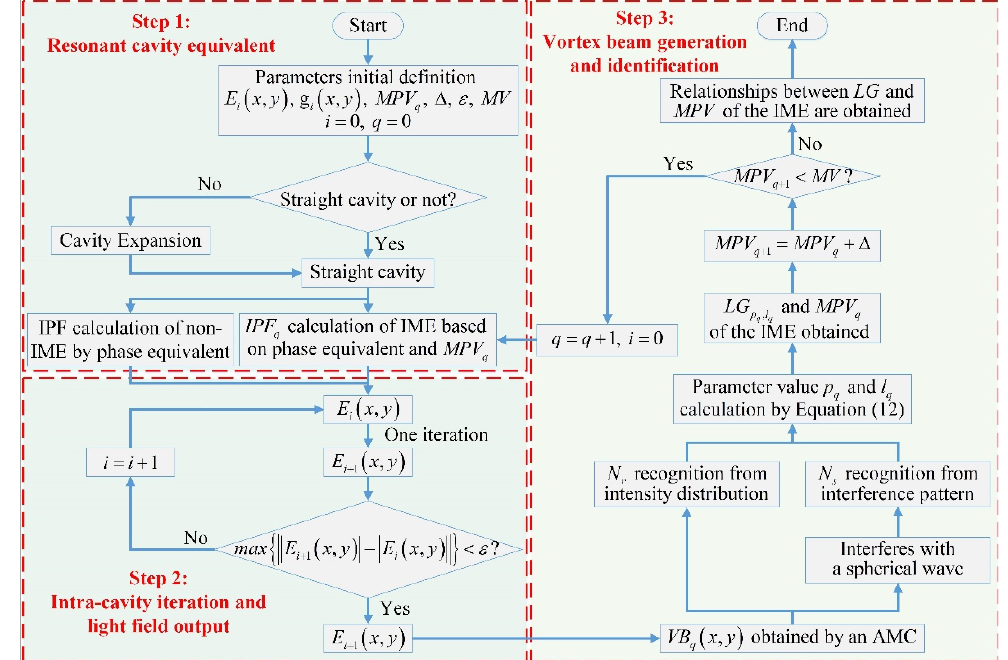
Figure 6. Working process of the MORA method.